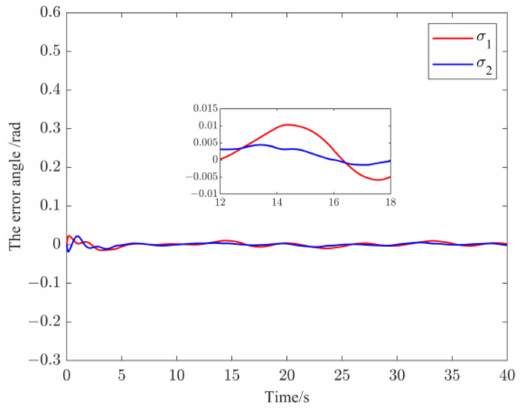
Figure 9. The output error (cid:101) x when u p is off.